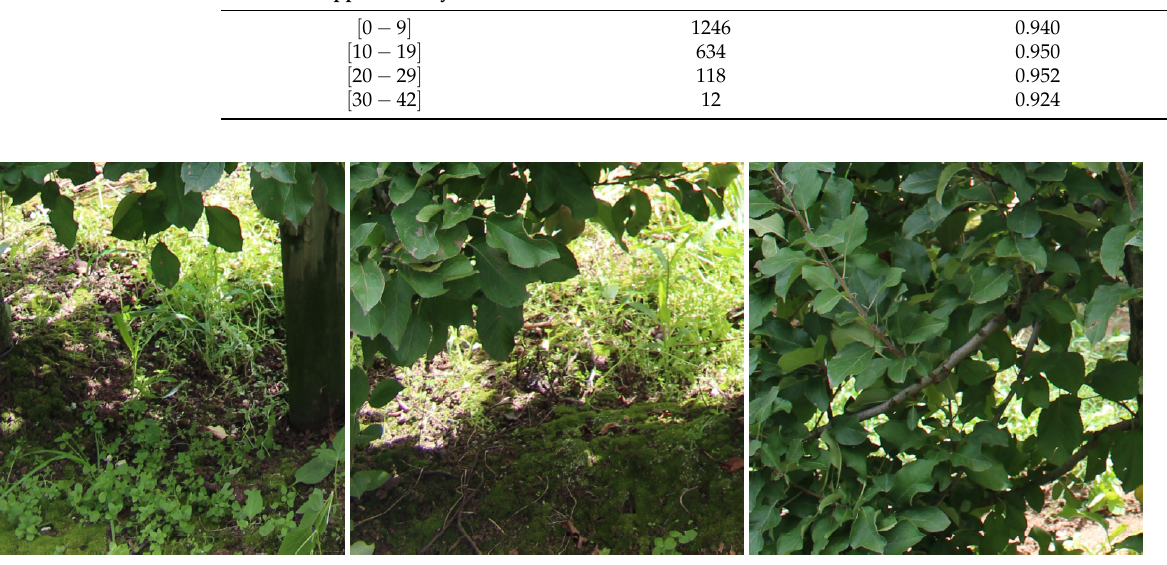
Figure 9. Examples of patches without